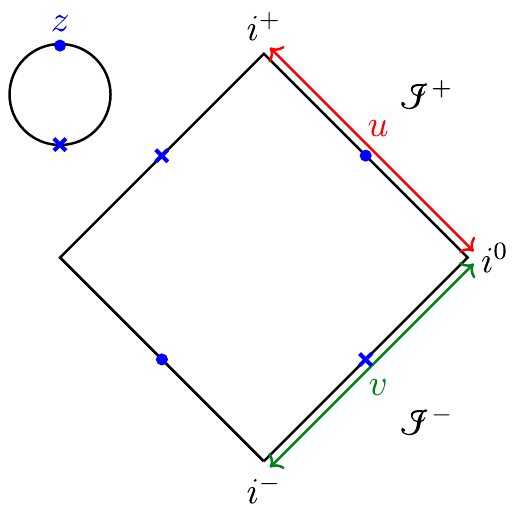
Fig. 1 Penrose diagram for Minkowski space. Massive particles enter and exit at past ( i − ) and future ( i + ) timelike infinity. Massless excita- tionsenterandexitatpast( I − )andfuture( I + )nullinfinity.Meanwhile, the boundary of a Cauchy slice will limit to spatial infinity ( i 0